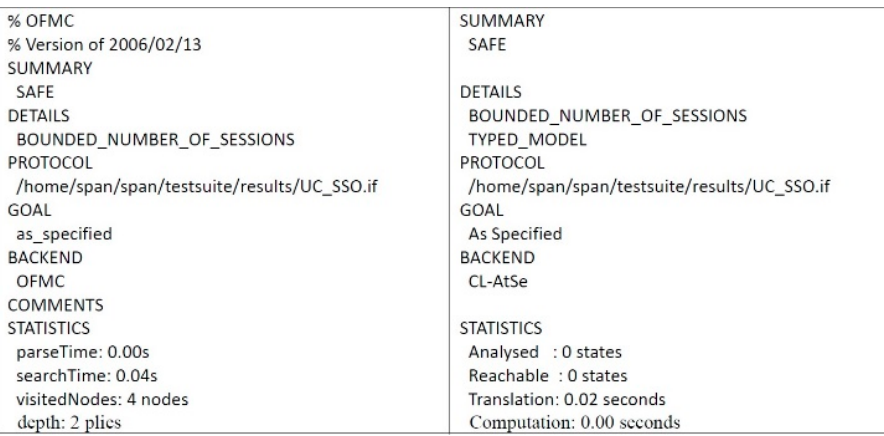
Figure 9. Results of AVISPA.